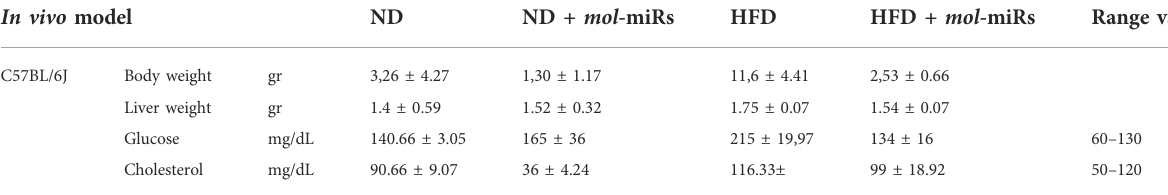
TABLE 4 Effect of mol- miRs on mice.